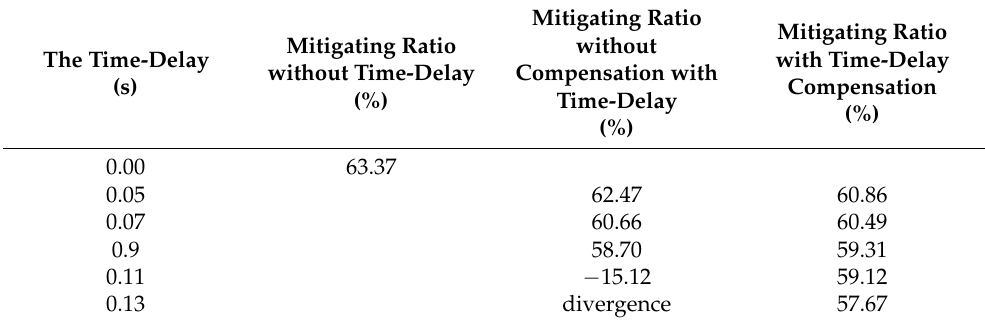
Table 4. Response reduction at mid-span of three control strategies under random excitation.